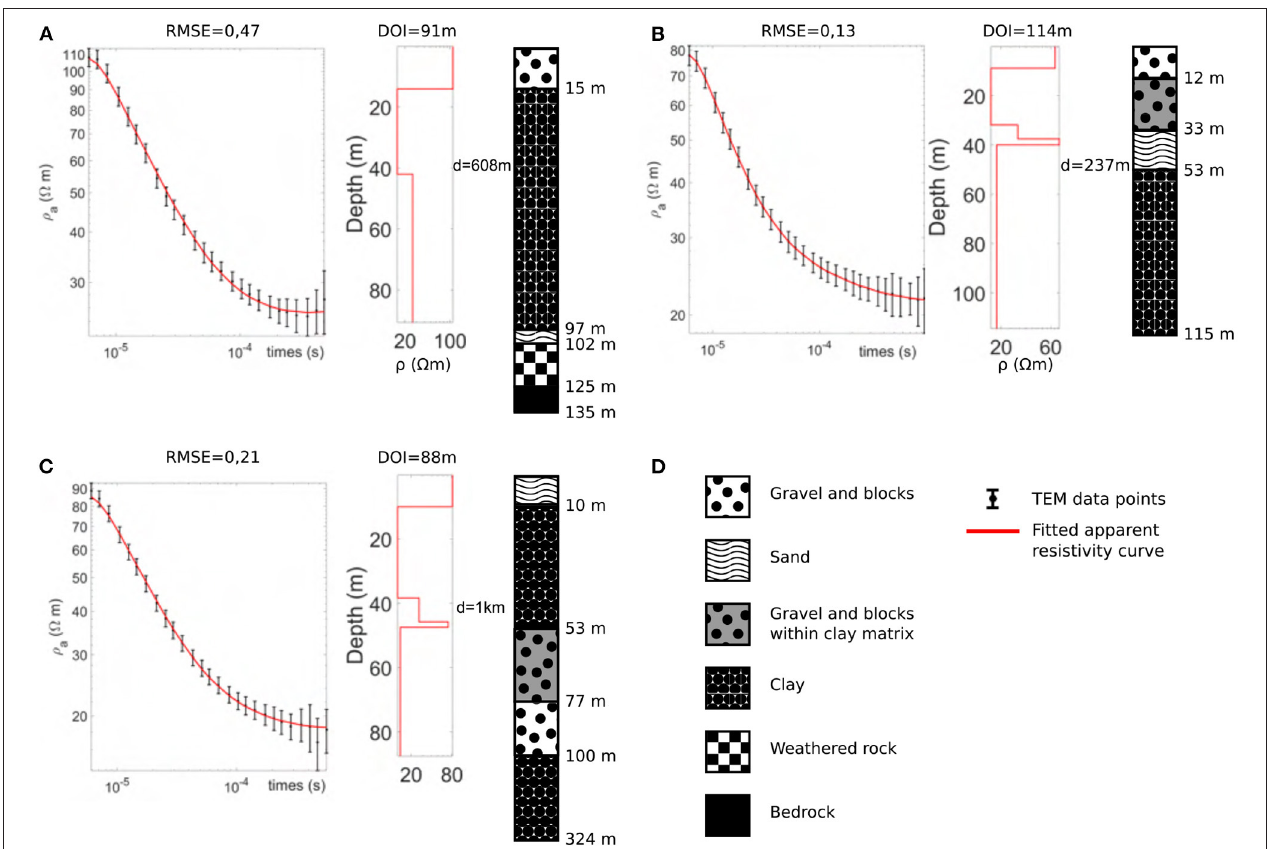
FIGURE 8 | Example of correlation between 1D modeled resistivity obtained from SCI-FL inversion and stratigraphic bore logs in the sector of hydrogeological continuity Limarí river upstream of Altos de Talinay. (A–C) TEM acquired data with fitted apparent resistivity curve and RMSE, 1D resistivity profiles with specified maximum depth of exploration (DOI) and closest bore log with indication of distances, d , between them. (D) Legend of the symbols used.